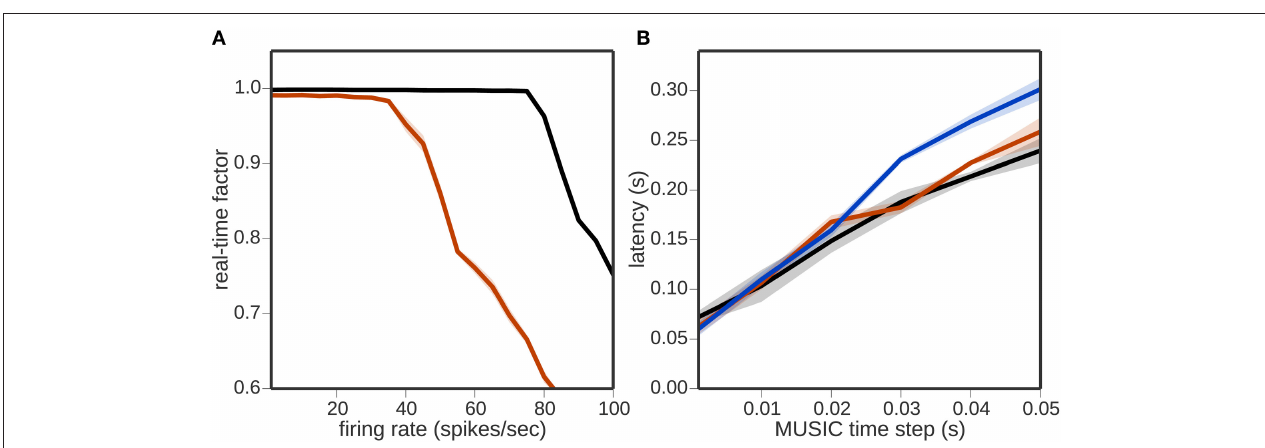
FIGURE 3 | Bandwidth limitations of the toolchain. (A) Real-time factor as a function of neuronal firing rate per neuron for a regular rate encoder of 50 , 000 neurons without a neural simulator (black curve) and with NEST (red curve). (B) Latency as a function of MUSIC time step without a neural simulator (black curve), with NEST (red curve) and with NEURON (blue